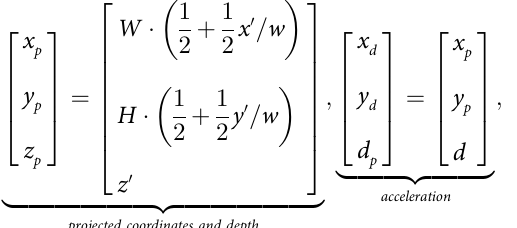
p ffiffiffiffiffiffiffiffiffiffiffiffiffiffiffiffiffiffiffiffiffiffiffiffiffiffiffiffiffiffiffi þ p 2 þ p 2 p 2 1 ; 1 1 ; 2 1 ; 3 ffiffiffiffiffiffiffiffiffiffiffiffiffiffiffiffiffiffiffiffiffiffiffiffiffiffiffiffiffiffiffi p þ p 2 þ p 2 p 2 2 ; 1 2 ; 2 2 ; 3 ffiffiffiffiffiffiffiffiffiffiffiffiffiffiffiffiffiffiffiffiffiffiffiffiffiffiffiffiffiffiffi þ p 2 þ p 2 p 2 3 ; 1 3 ; 2 3 ;